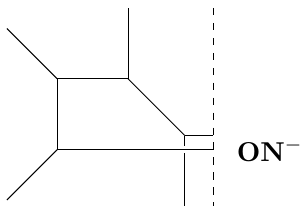
Figure 5 . The web diagram for the D 2 quiver theory.